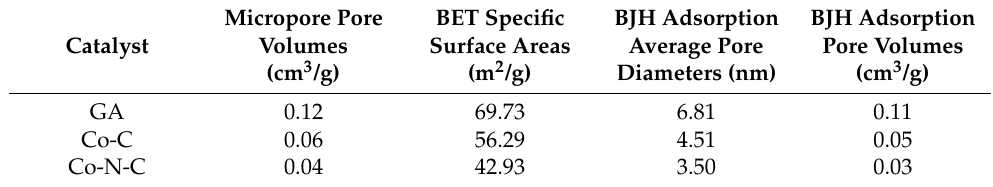
Figure 2. ( a ) XRD, ( b ) FT-IR, and ( c ) N 2 adsorption–desorption isotherms and the BJH pore size distributions of GA, Co-C, and Co-N-C. XPS ( d ) survey, ( e ) C 1s, and ( f ) N 1s spectrum of GA, Co-C, and Co-N-C. Table 1. Pore structures of GA, Co-C, and Co-N-C.